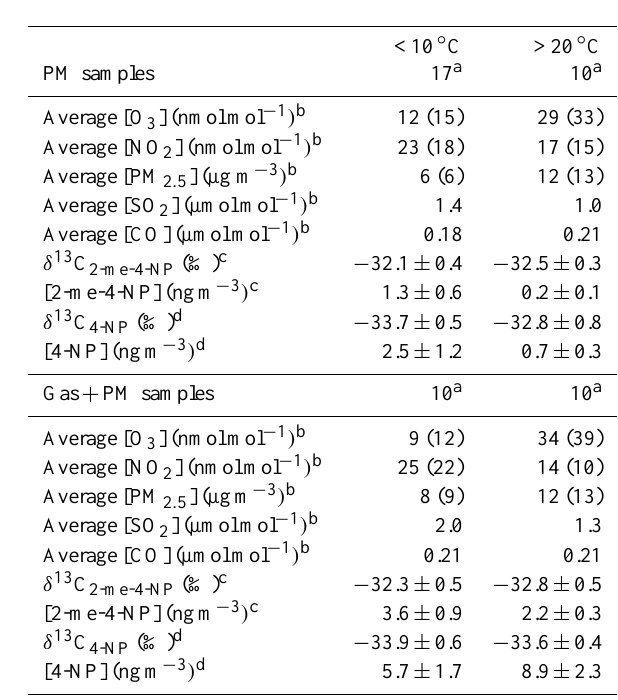
Table 6. Average of measured 2-methyl-4-nitrophenol concentra- tions and carbon isotope ratios for different daily average tempera- tures. For comparison, air quality data from two monitoring sites of OME are also shown.